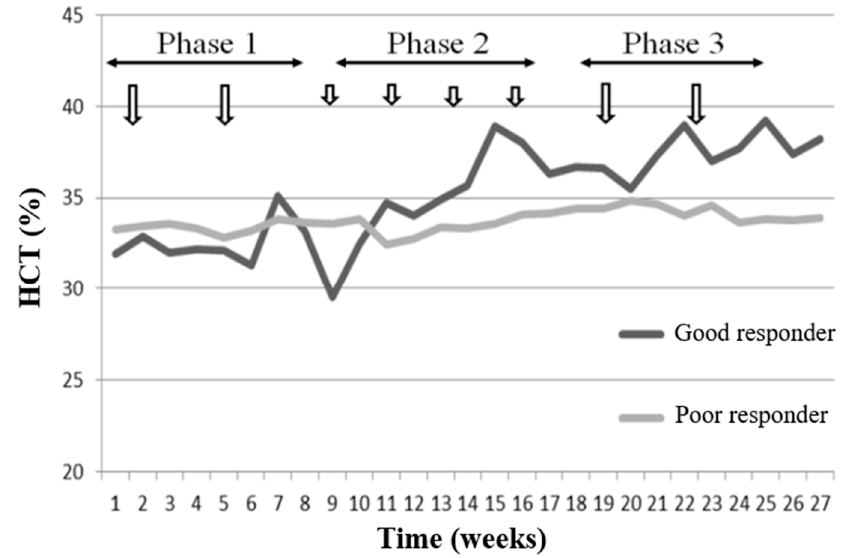
Figure 1. Mean HCT levels of GR and PR during the 27-week study (arrows indicate the timing of CERA injection, 100 µcg for phases 1 and 3 and 50 µcg for phase 2). Abbreviations: HCT, hematocrit;